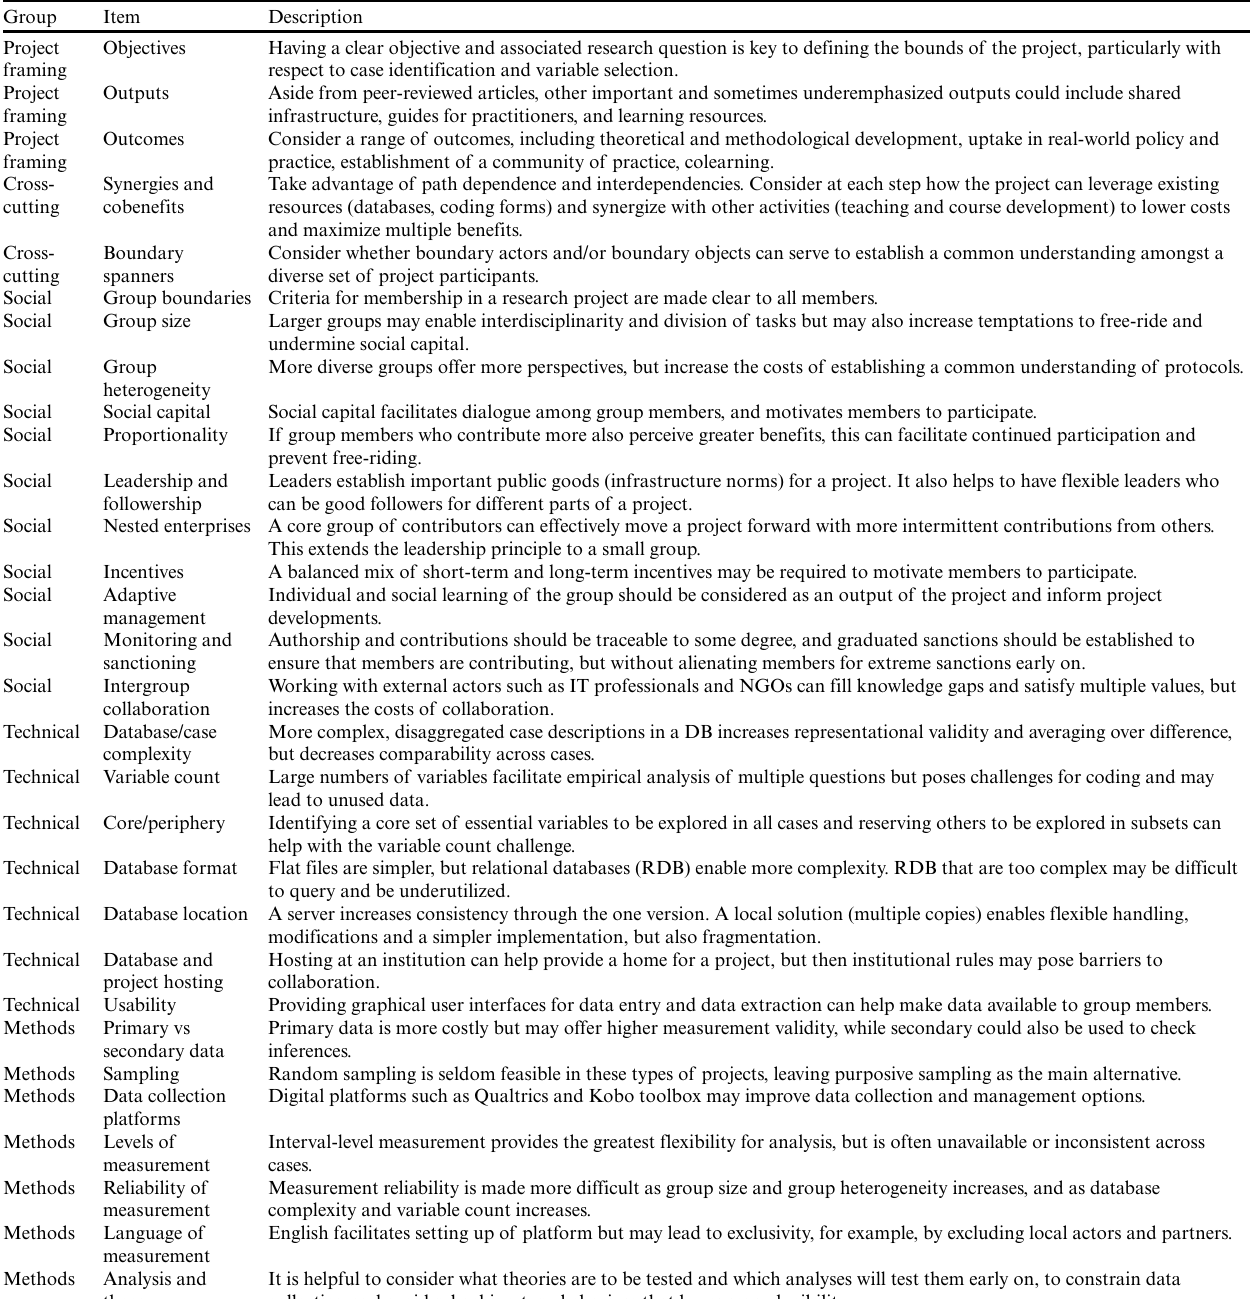
Table 2 . Checklist of issues to consider when developing broadly comparative research projects. The items are divided into the following groups: (1) project framing, (2) social considerations, (3) technical considerations, and (4)